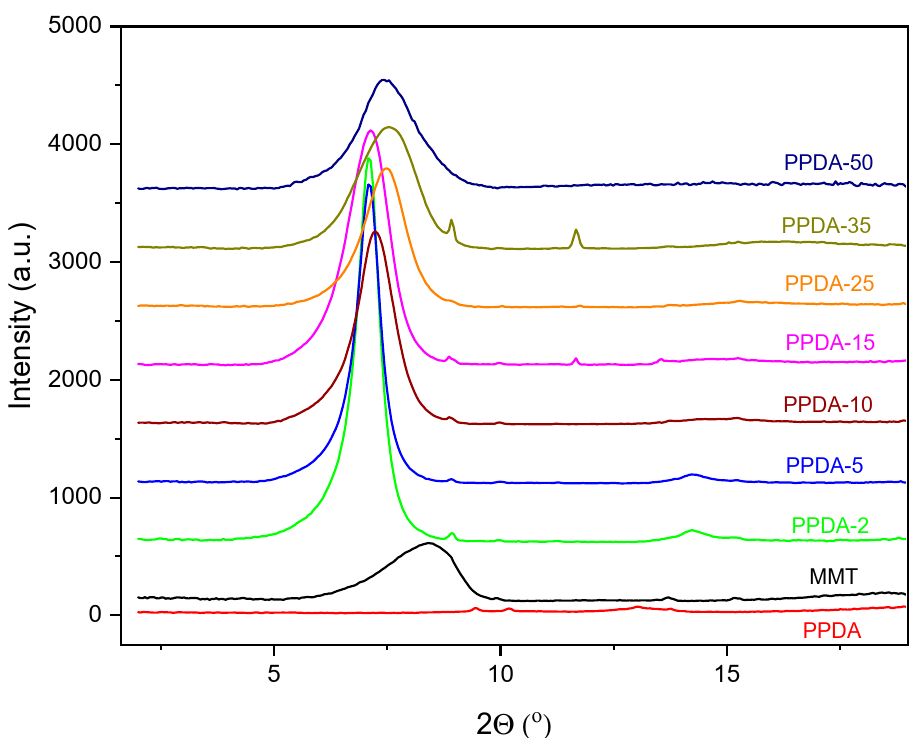
Figure 3. XRD patterns of pristine MMT, PPDA and their composites.